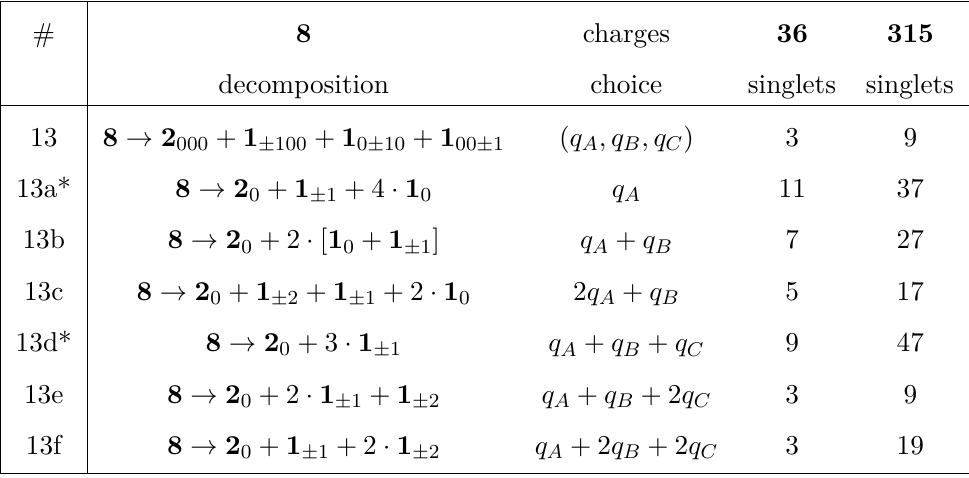
Table 6 . Branchings for the case